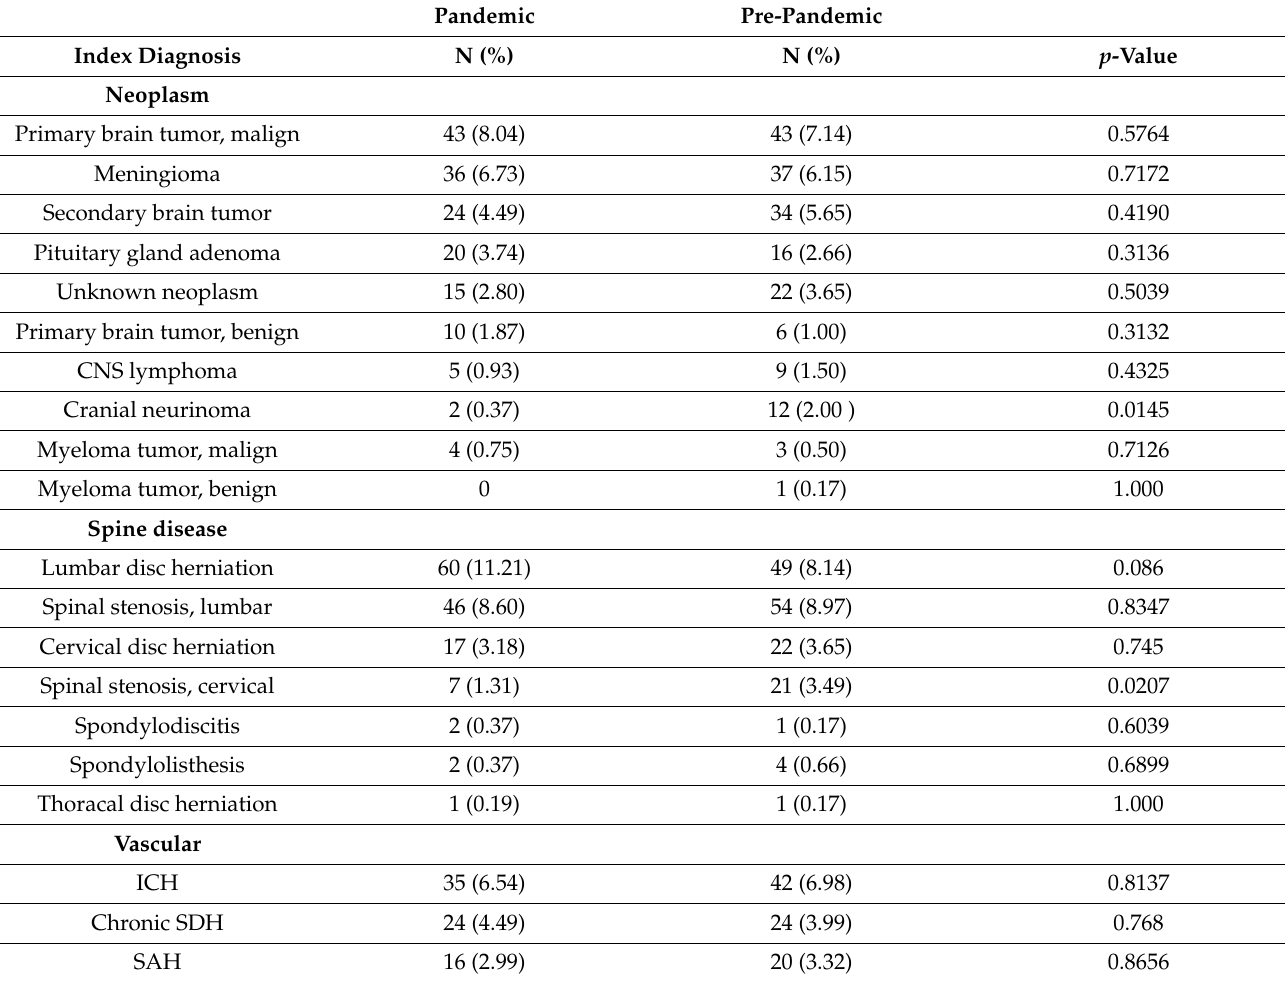
Table 2. Index diagnoses for neurosurgical admission in the pandemic and pre-pandemic patient